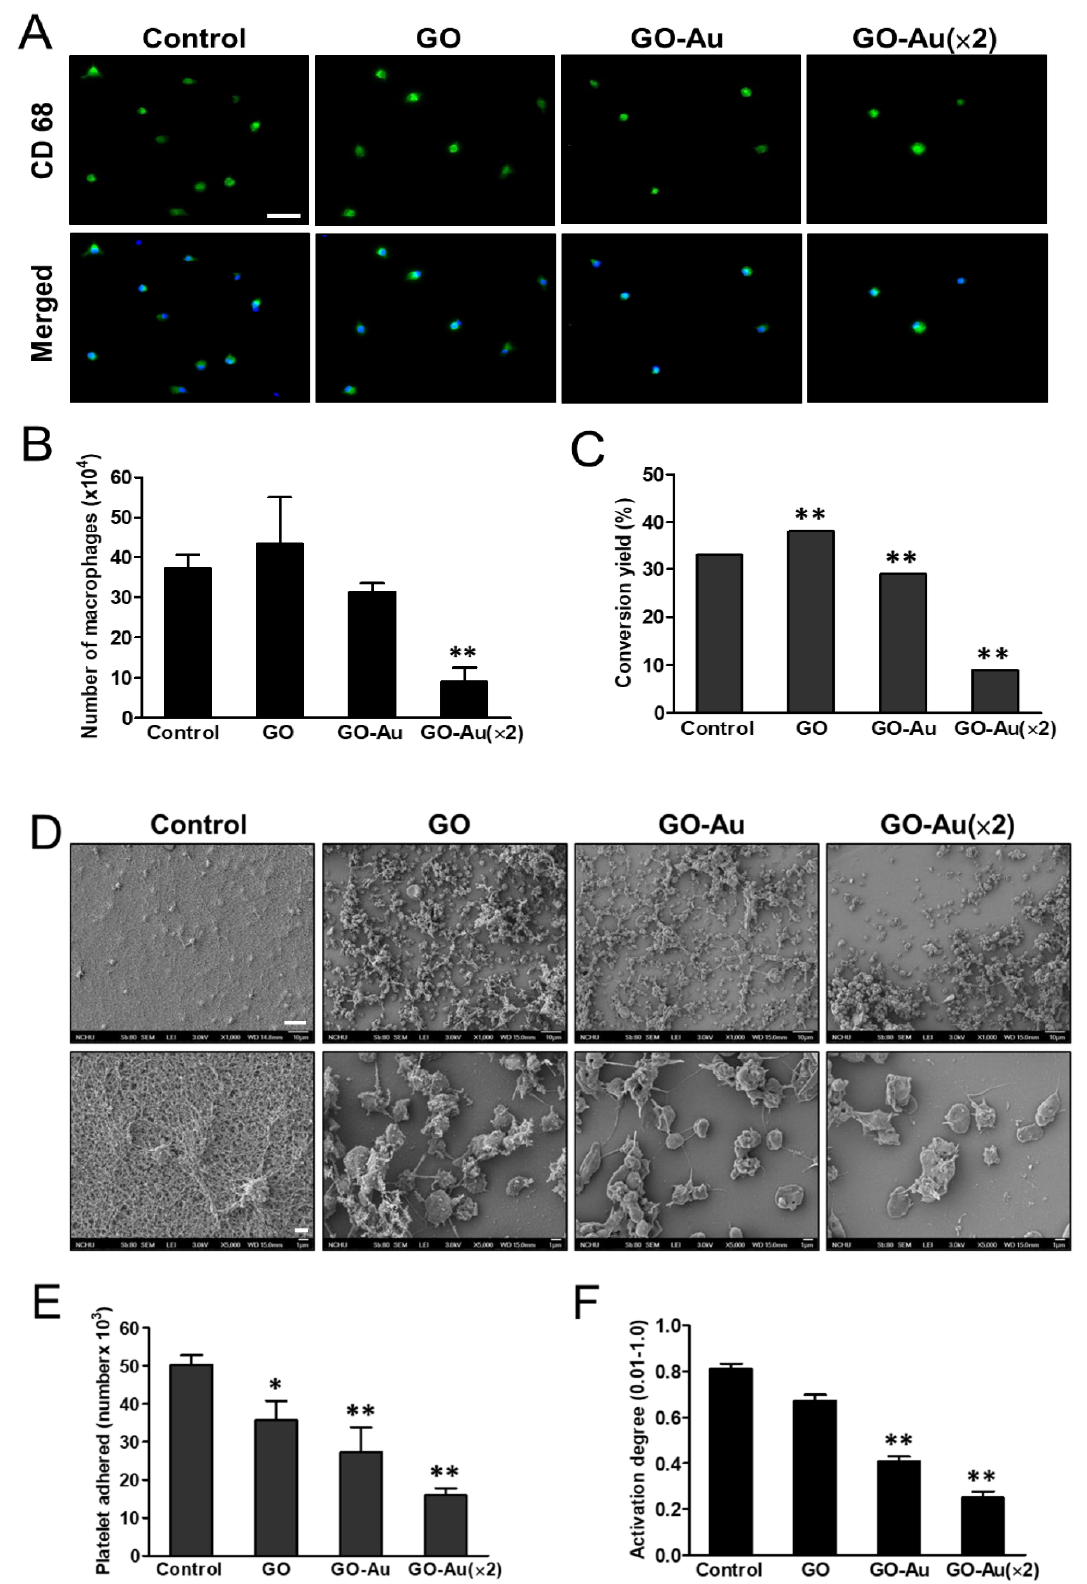
Figure 3. Effects of different materials on macrophage activation. Monocytes were isolated from whole blood and were incubated on various nanocomposites of GO, GO-Au, and GO-Au (×2) for 96 h. ( A ) Macrophage marker CD68 (green) was examined using an immunofluorescence staining. Cell nuclear was stained with DAPI (blue). The positive